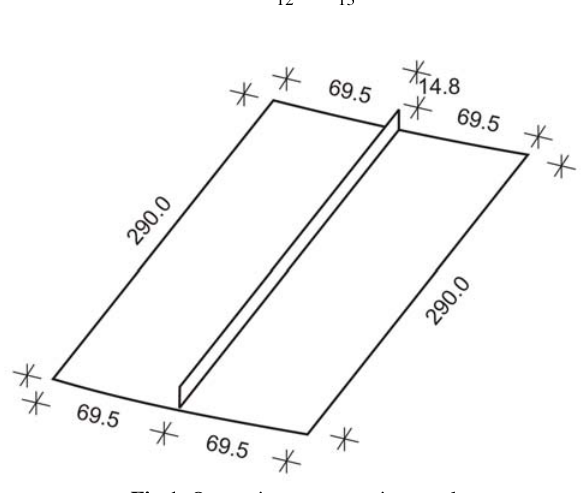
Fig 1. One-stringer composite